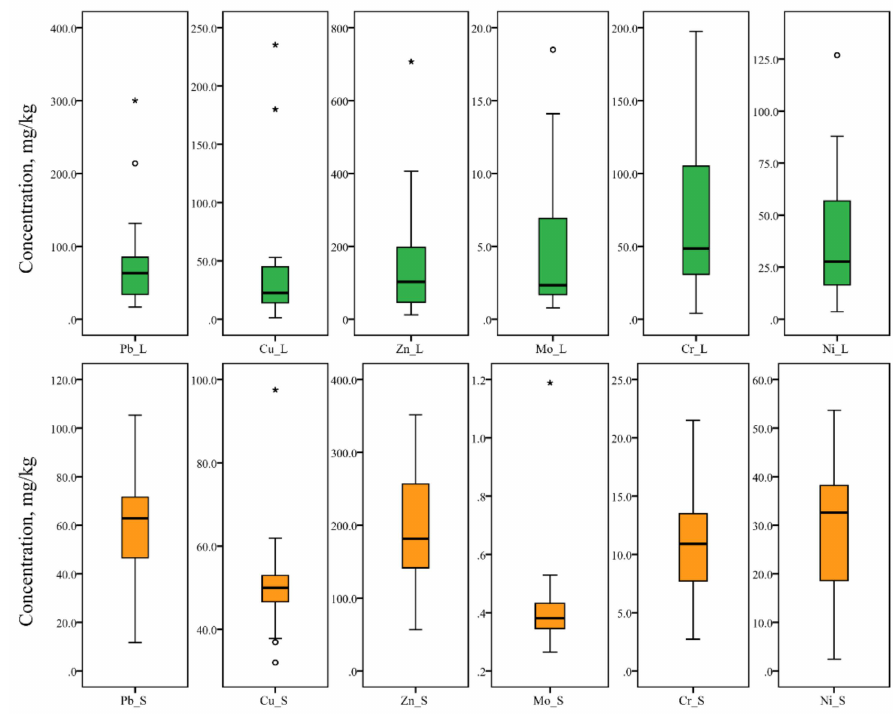
Figure 3. Box plots of studied PTE concentration in Gyumri’s tree leaf-deposited PM and soil (o—outliers and *—extreme